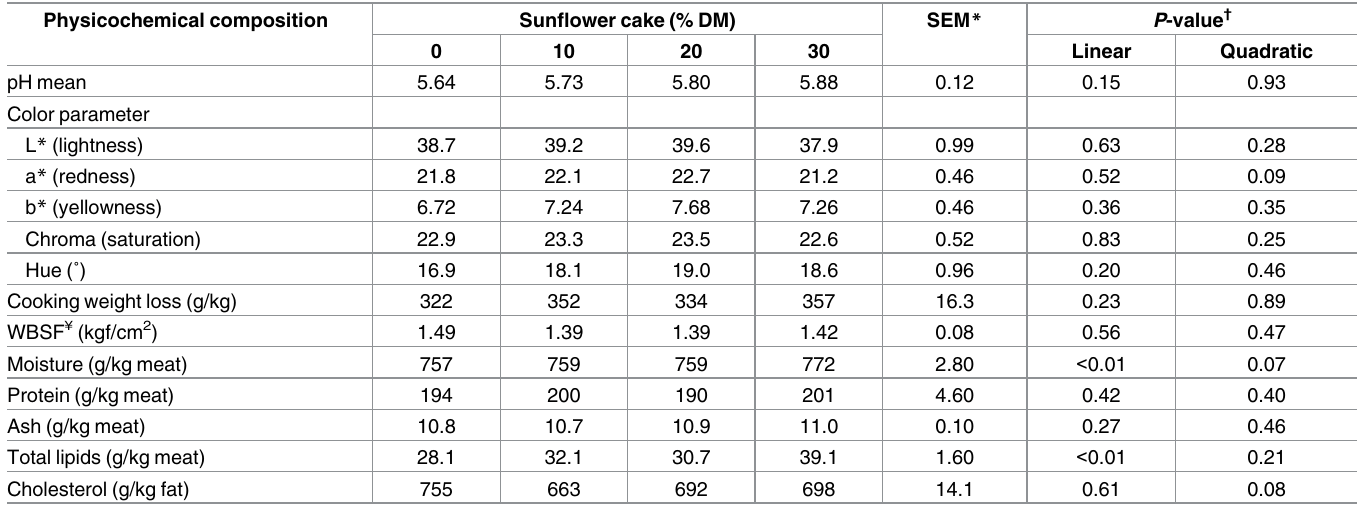
Table 3. Physicochemical composition of the longissimus lumborum muscle of Santa Ines lambs fed sunflower cake. Physicochemical